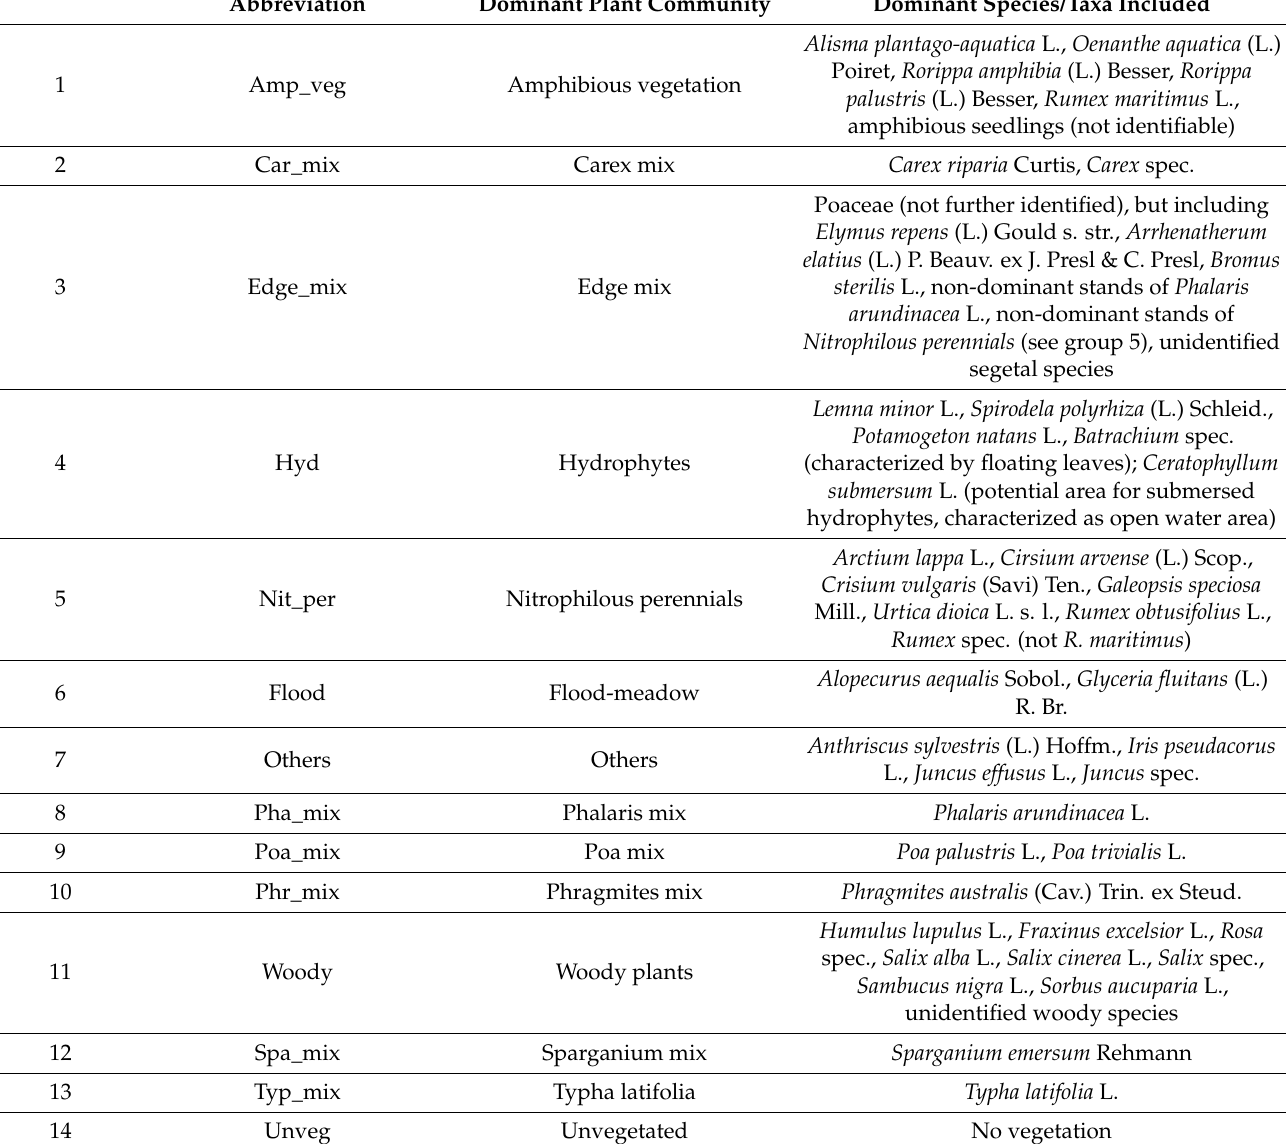
Table 3. Assignment of the digitally mapped dominant species/taxa into 14 final dominant plant